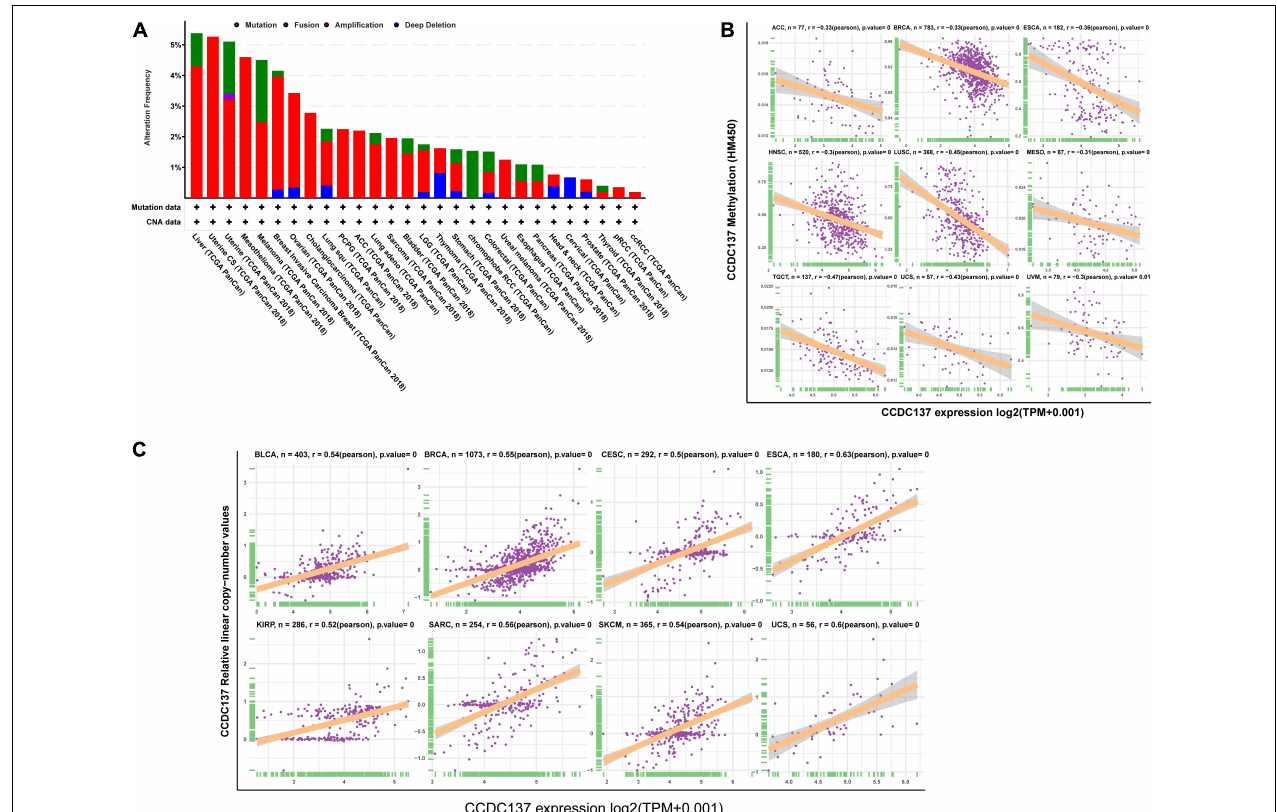
FIGURE 3 | Pan-cancer analysis of CNA and DNA methylation of CCDC137. (A) CNA and mutation frequency of CCDC137 in TCGA pan-cancer were accessed using cBioPortal. (B) The correlation between DNA methylation and mRNA expression of CCDC137 in TCGA pan-cancer. (C) The correlation between CNA and mRNA expression of CCDC137 in TCGA